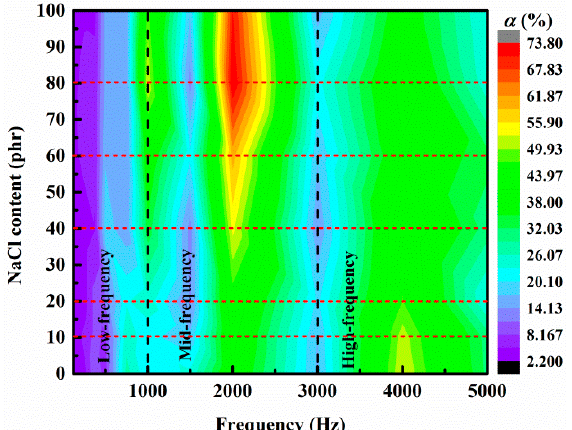
Figure 5. Frequency dependent sound absorption coefficient of silicon rubber foams with different added amounts of NaCl.